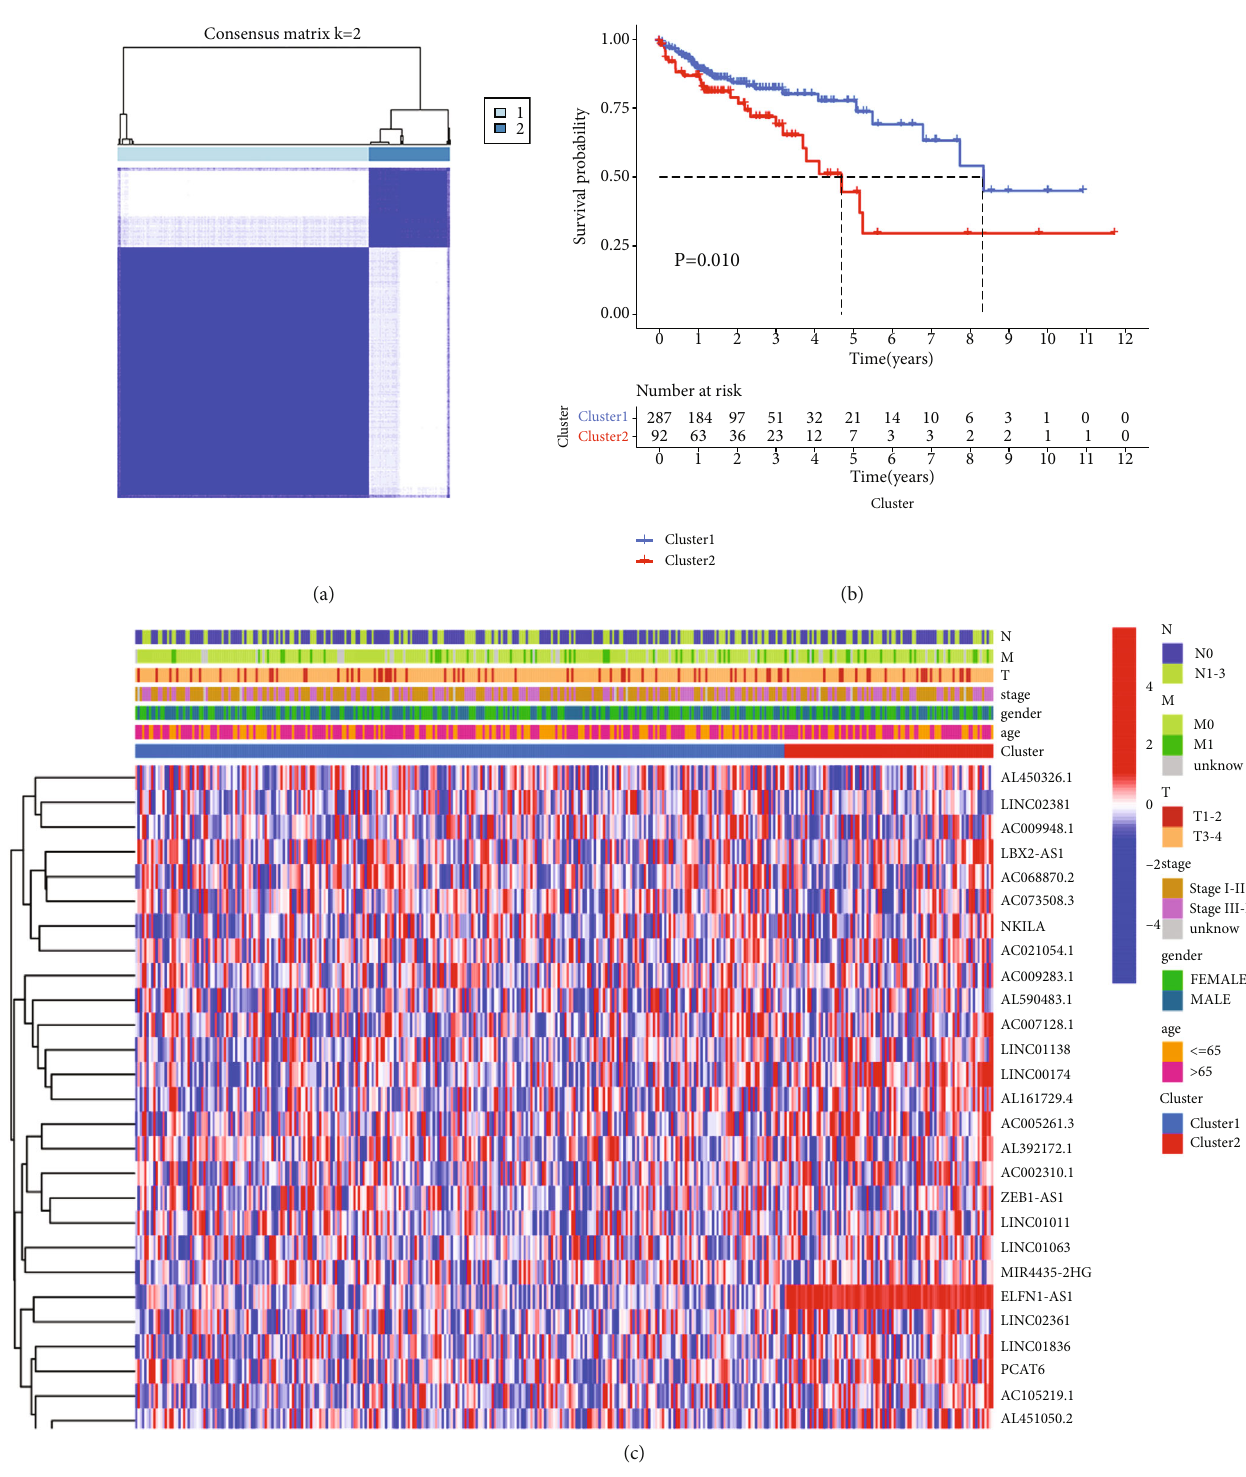
Figure 2: Di ff erential clinicopathological features and overall survival of colon cancer patients in clusters 1 and 2. (a) Consensus clustering matrix for k = 2 . (b) The Kaplan-Meier curves of overall survival (OS) for patients with colon cancer in clusters 1 and 2; p < 0 : 05 . (c) Heatmap and clinicopathologic features of clusters 1 and